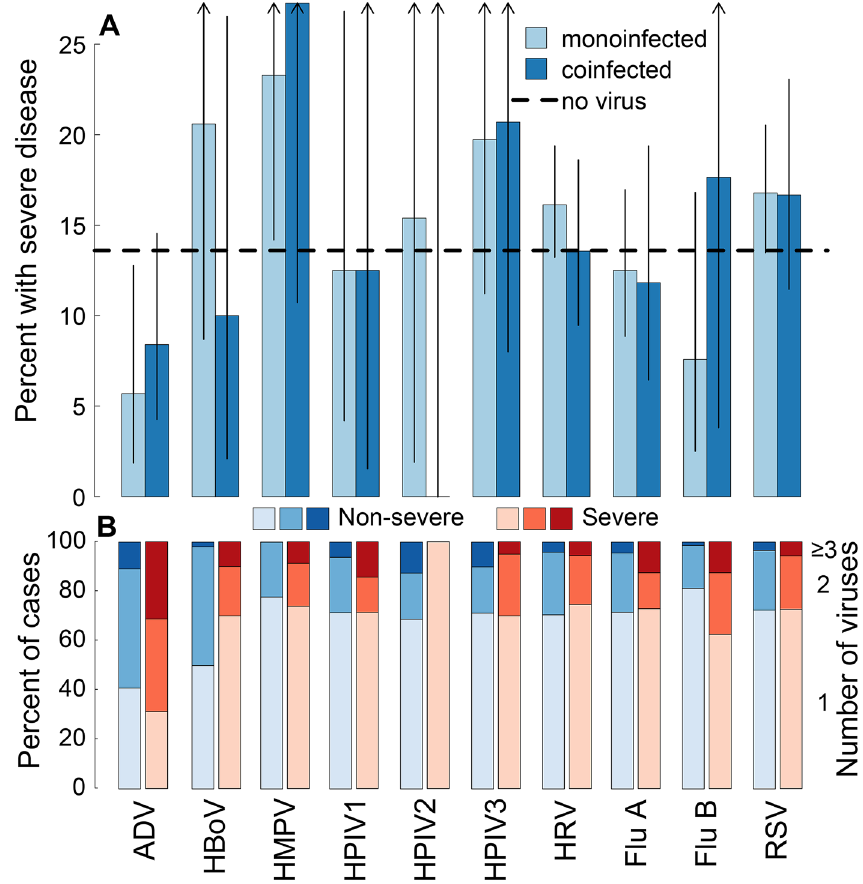
Figure 3. Percent of patients with severe disease by virus for no-, mono-, and multiple-infections and percent of severe and non-severe cases by virus and number of viruses detected in the NP sample. Panel ( A ) shows the percent of patients suffering severe disease (CSS > 3 ) by virus and whether the patient was PCR negative (dashed black line), PCR positive for 1 virus (light blue), or PCR positive for more than 1 virus (dark blue). Line segments indicate 95% binomial confidence intervals. Panel ( B ) show the percent of severe and non- severe patients by virus and PCR positive for 1, 2, or ≥ 3 viruses, respectively. ADV Adenovirus, HBoV